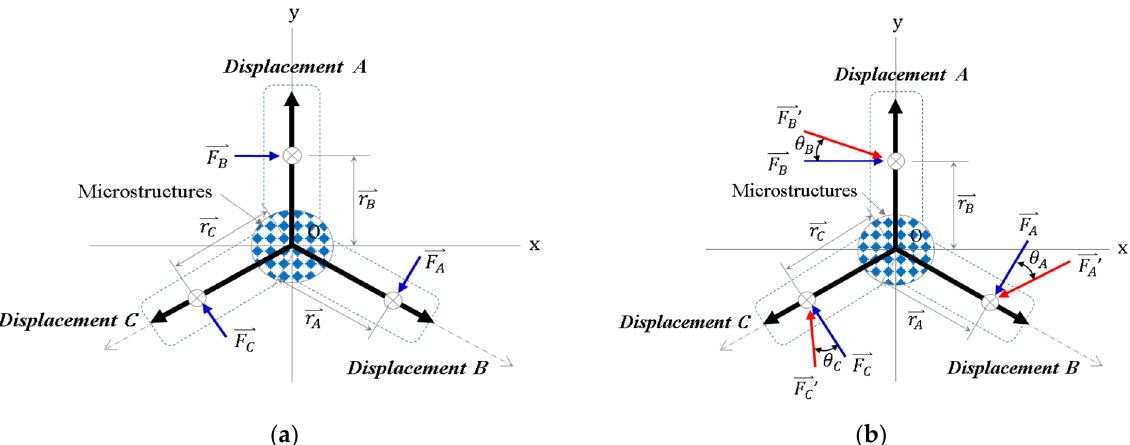
Figure 2. Effects of multi-directional stretching on the mold under external force: ( a ) forward external thrust and ( b ) angled external thrust.